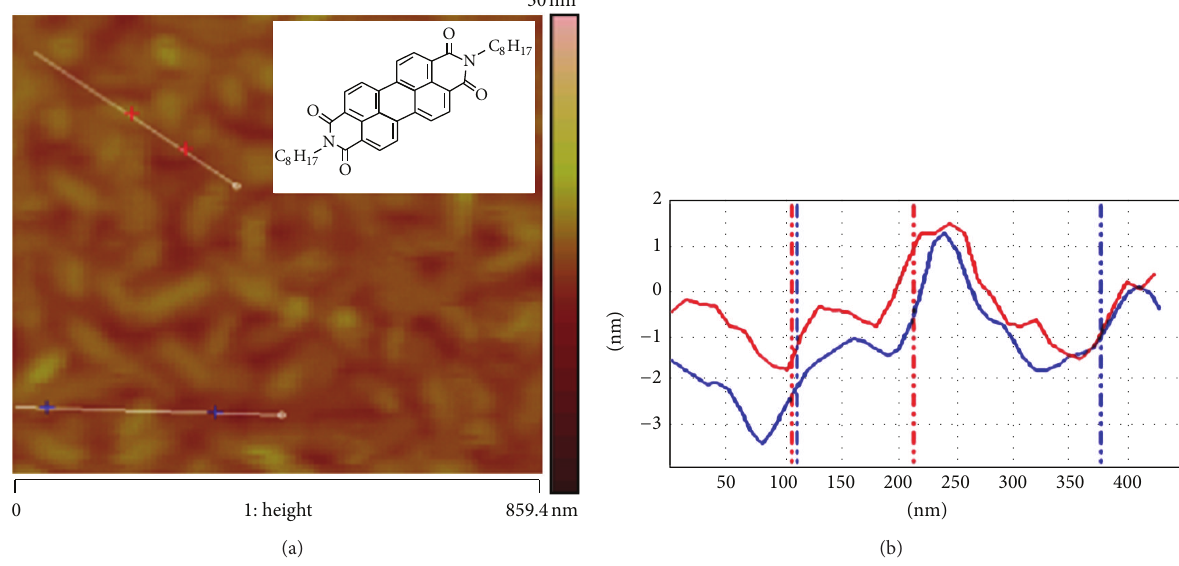
Figure 2: Line scans of the terraces which show monomolecular steps of 2nm for 27nm of PTCDI-C8 on Si. The inset presents the chemical structure of PTCDI-C8.